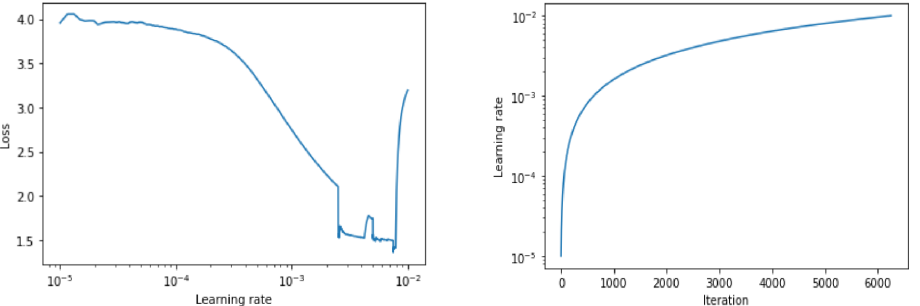
Figure 8. On the left is a graph of learning rate vs. loss to find the range of optimal values of LR; on the right, the iterations vs. learning